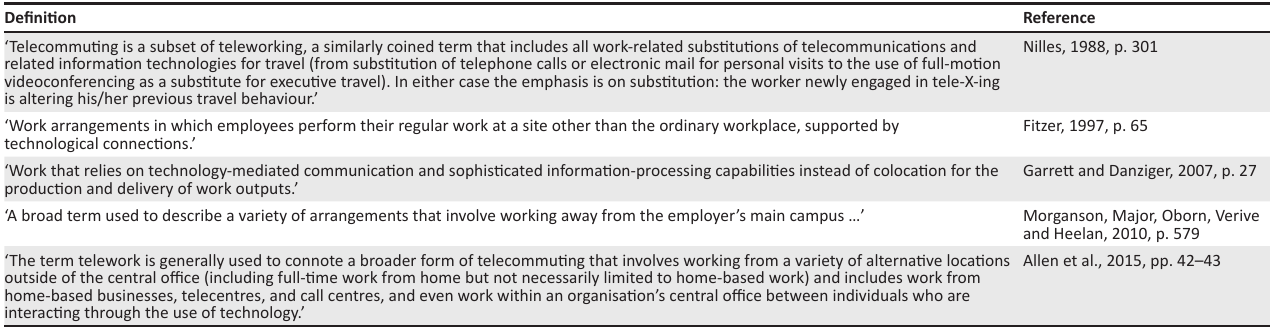
TABLE 1: A selection of telework